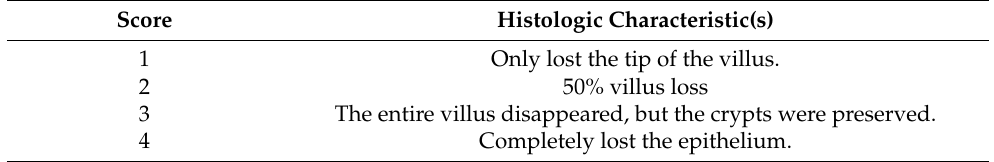
Completely lost the